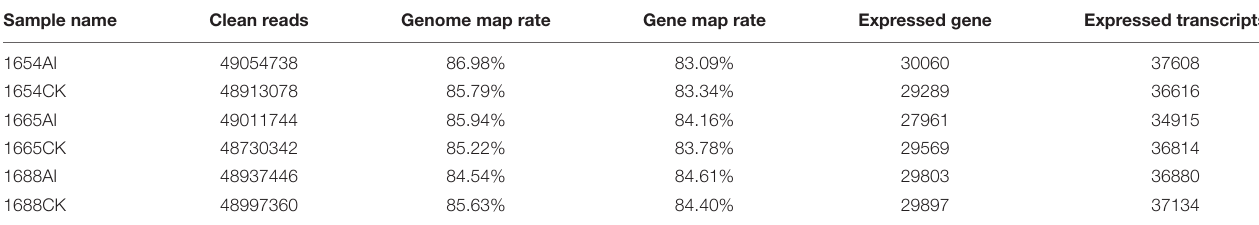
TABLE 5 | Sequence and assembly summary of